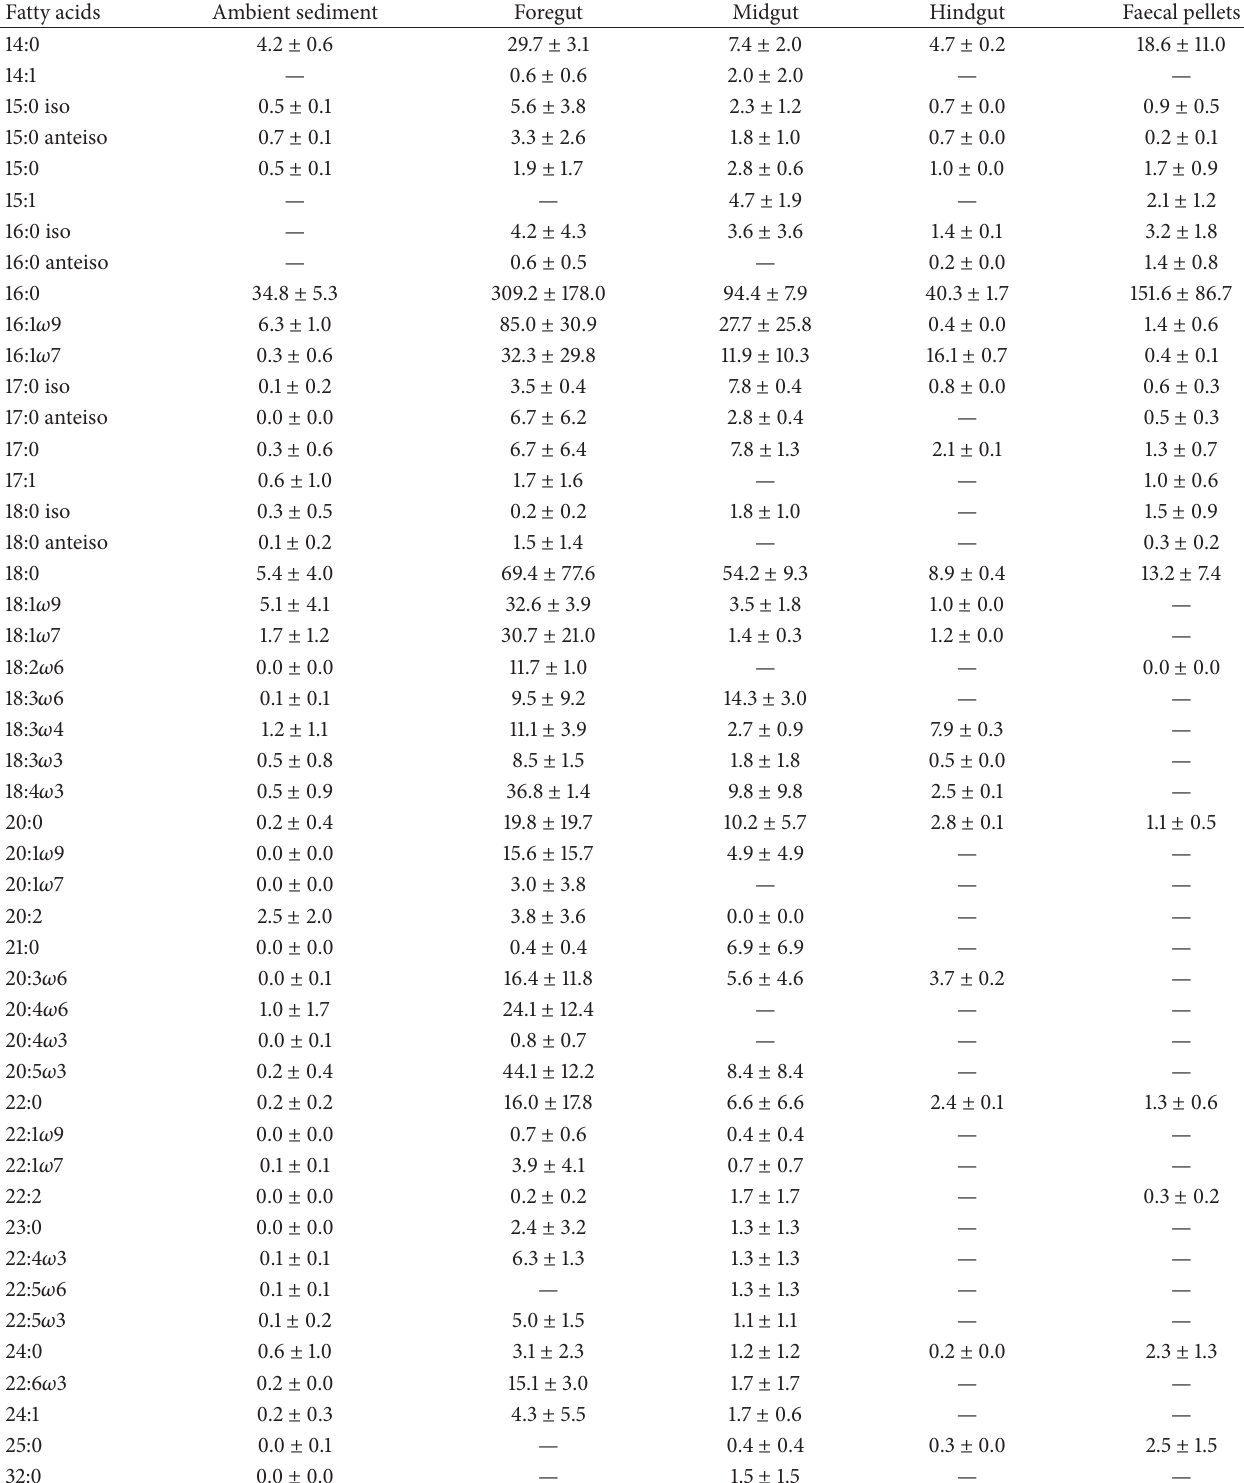
Table 2: Fatty acid composition ( 𝜇 g g −1 dry weight) of ambient sediment, foregut, midgut, hindgut, and faecal pellets of Holothuria leucospilota